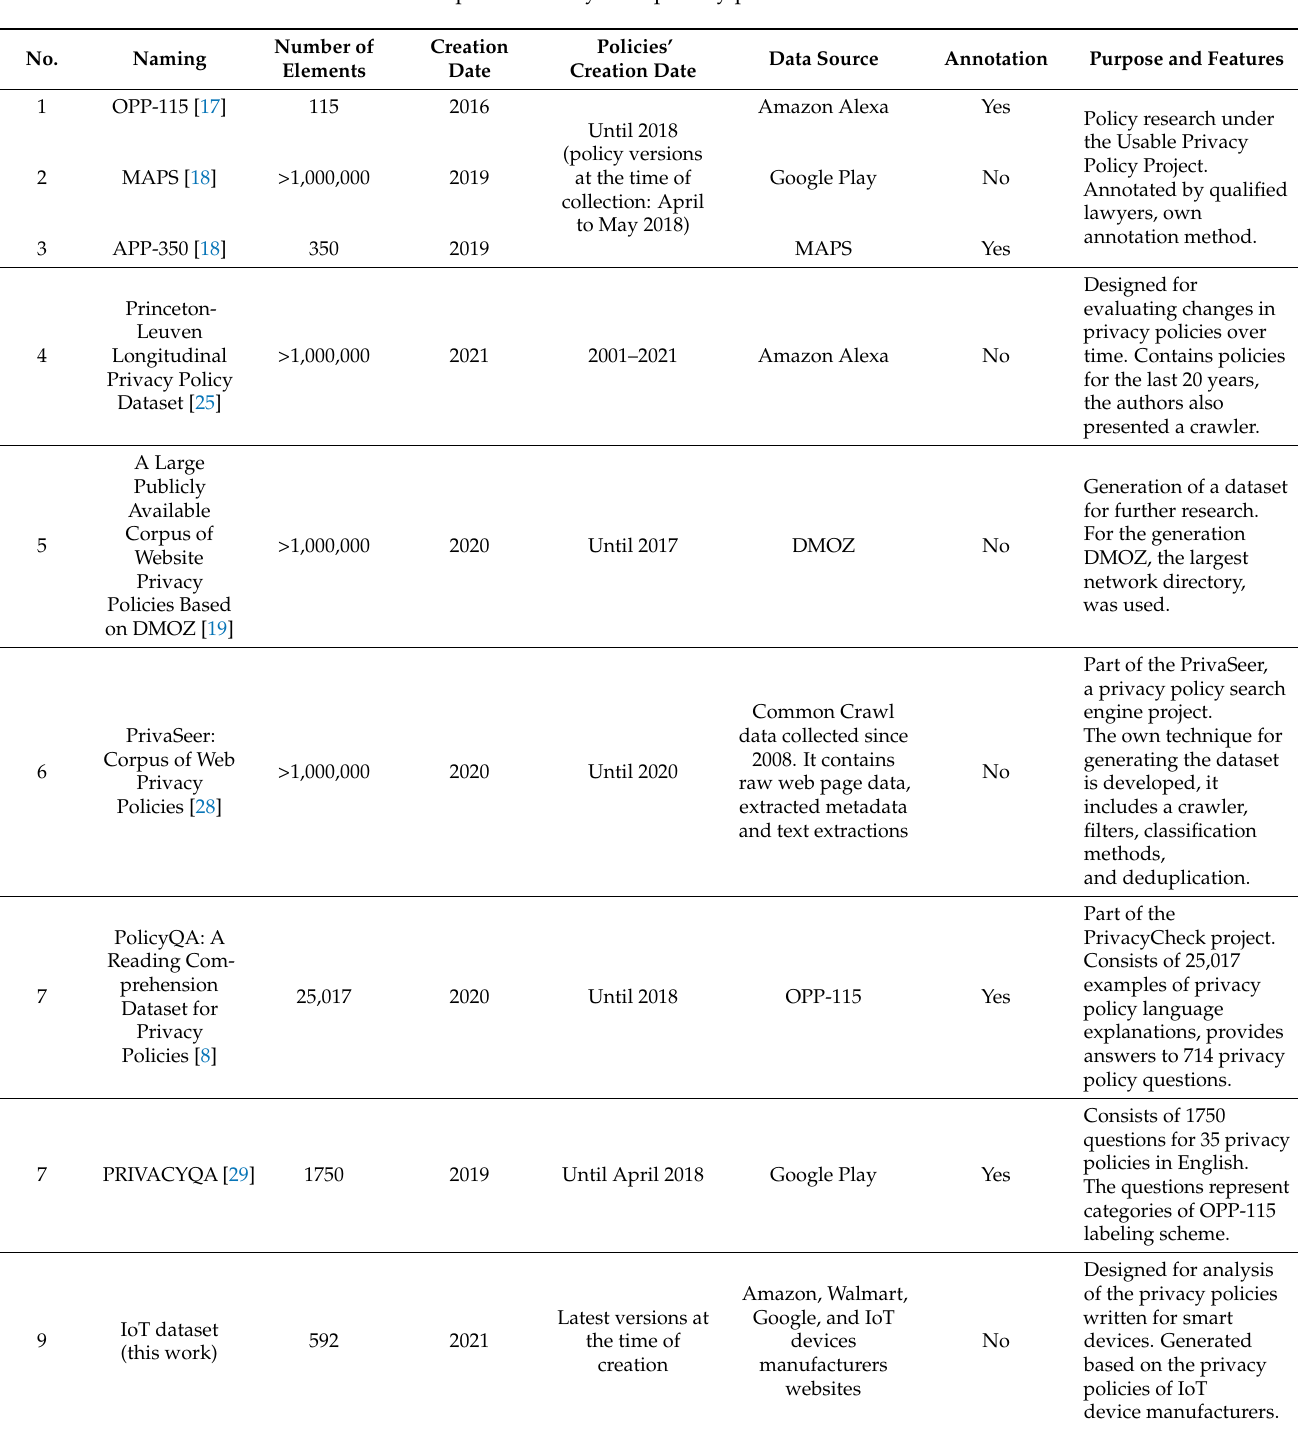
Table 1. Comparative analysis of privacy policies’